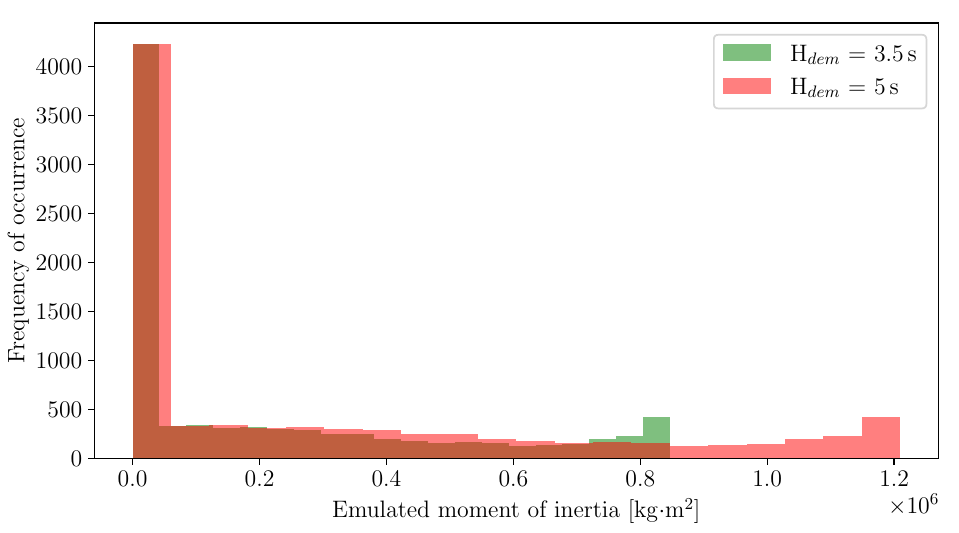
Figure 5. Depiction of the synthetic moment of inertia provided by WTs. The green bars depict the synthetic moment of inertia provided by WTs considering the demanded inertia constant ( H dem ) of 3.5s and the red bars depict the synthetic moment of inertia provided by WTs considering the demanded inertia constant of